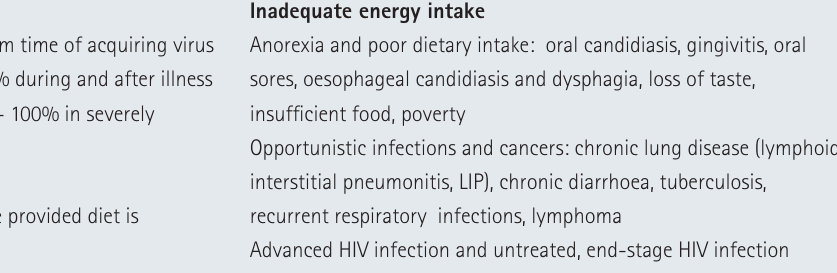
TABle 5.I. WeIGHT lOss IN HIV-INFeCTeD CHIlDReN – CAUses AND RelATIONsHIPs